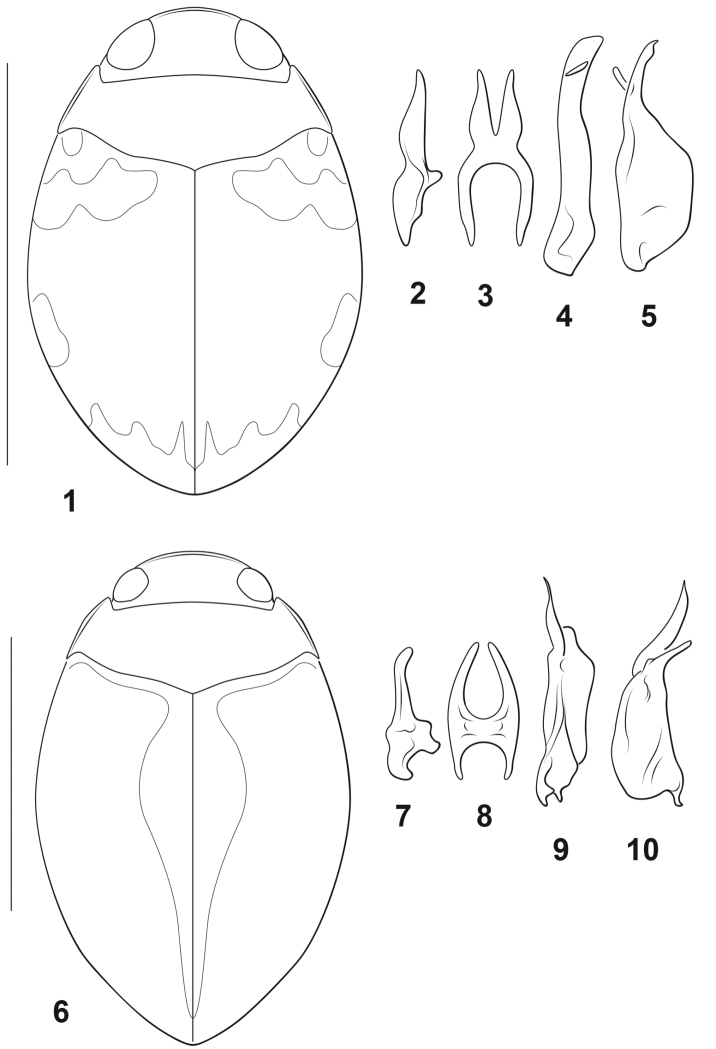
Desmopachria species. 1–5D.
manco1 habitus 2–5 male genitalia 2 male median lobe, right lateral aspect 3 male median lobe, ventral aspect 4 male left lateral lobe, ventral aspect 5 male left lateral lobe, left lateral aspect 6–10D.
mortimer6 habitus 7–10 male genitalia 7 male median lobe, right lateral aspect 8 male median lobe, ventral aspect 9 male left lateral lobe, ventral aspect 10 male left lateral lobe, left lateral aspect. Scale bars: 1.0 mm (1, 6).